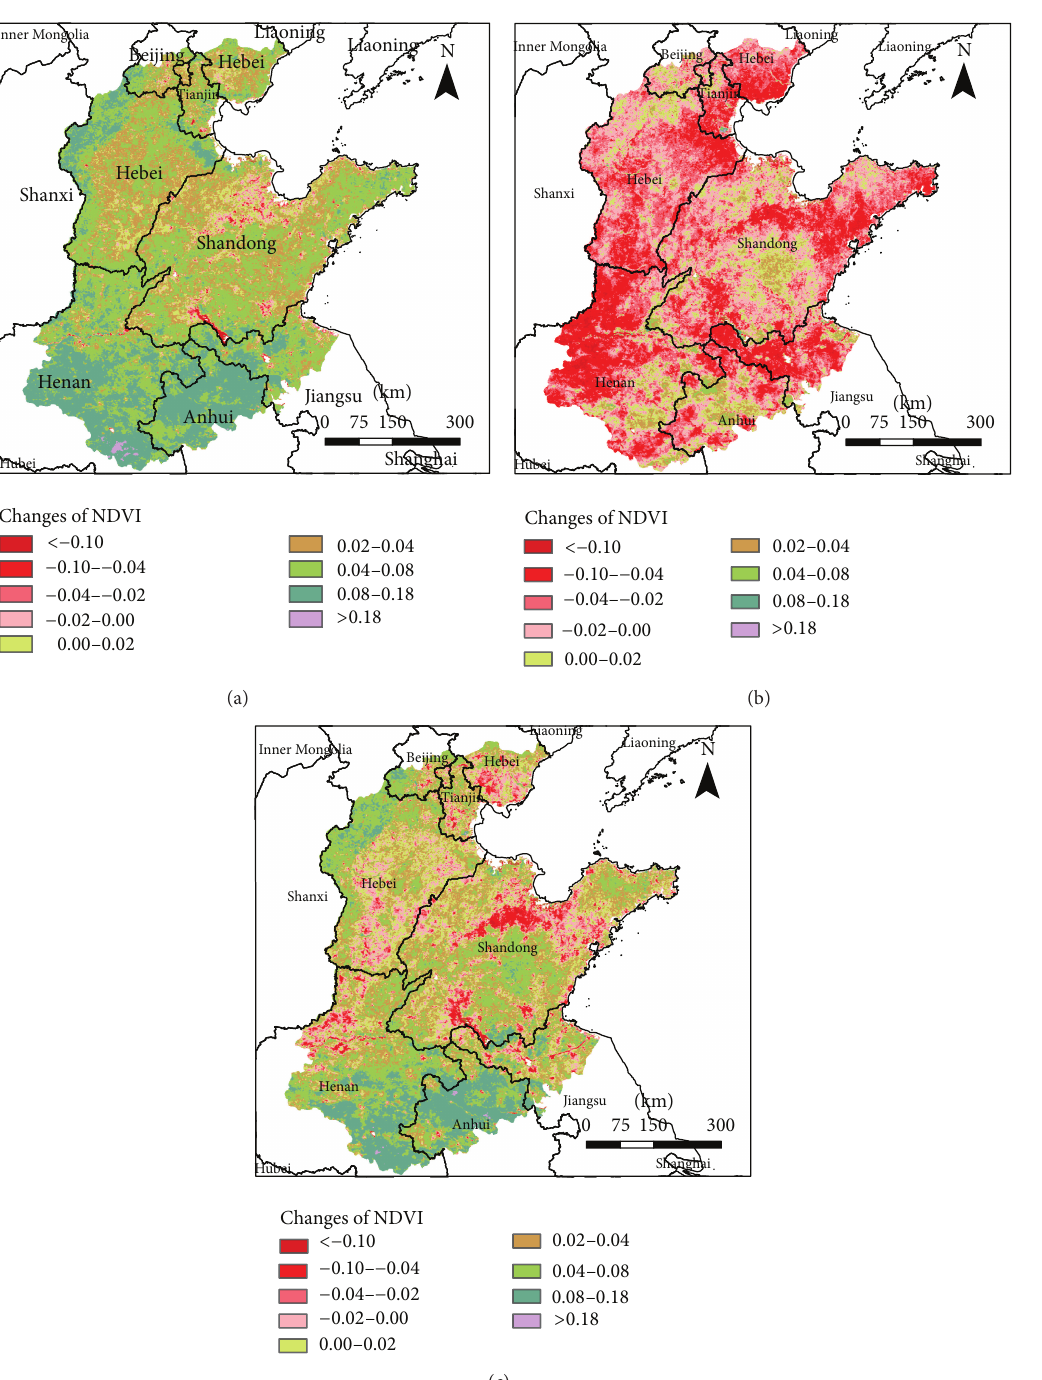
Figure 6: Changes of NDVI of the North China Plain during (a) 2000–2004; (b) 2004–2008; and (c)